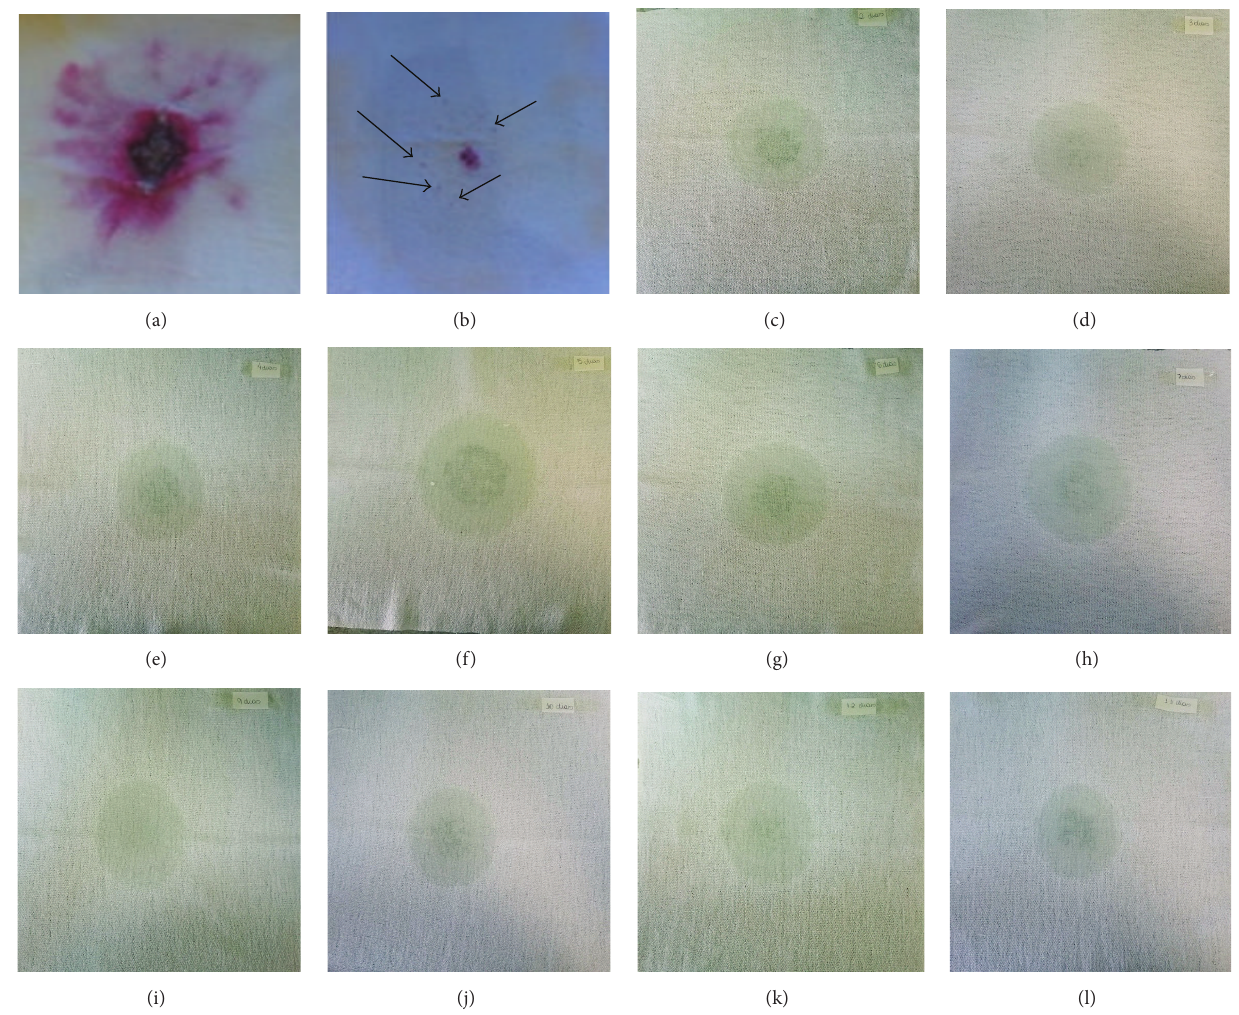
Figure 3: Colorimetric assay using sodium rhodizonate on white cotton containing GSR from one shot at (a) 0 cm and (b) 50 cm; and on solutions of the collected immature flies in the period of 2–12 days